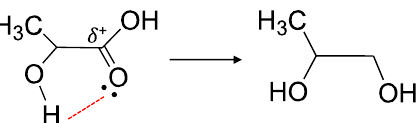
Figure 8. Hydrogenation of lactic acid to propane-1,2-diol.